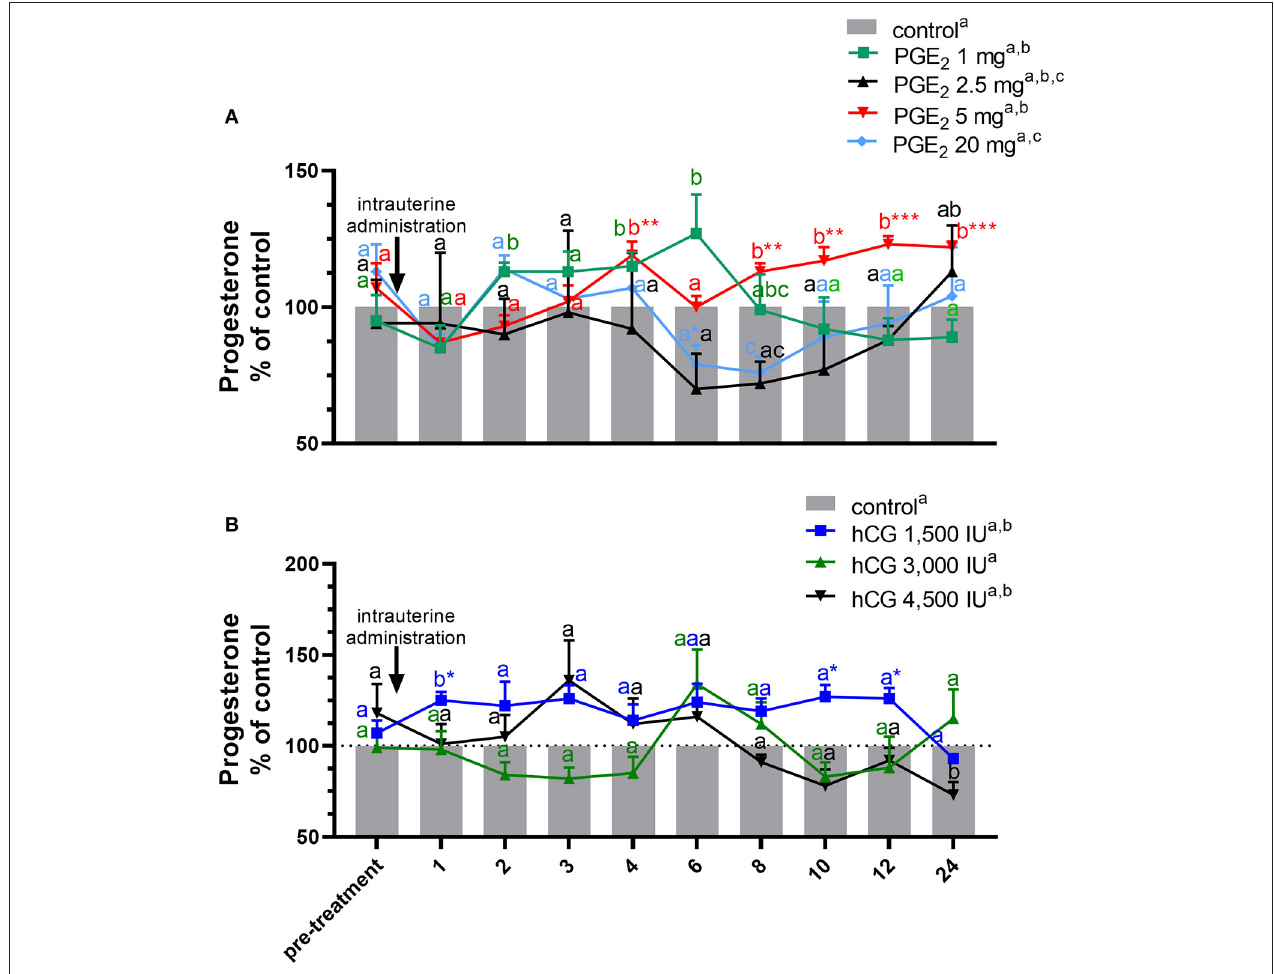
FIGURE 2 | Concentration of progesterone (P 4 ) in the jugular vein blood plasma in mares with one intrauterine administration of (A) four different doses of prostaglandin (PG) E 2 (PGE 2 ; 1, 2.5, 5, 20 mg/5ml, n = 3/dose) and (B) three different doses of human chorionic gonadotropin (hCG; positive control; 1,500, 3,000, 4,500 IU/5ml, n = 3/dose) on day 10 of the estrous cycle, compared with control groups. All values are presented as % of the control. Different superscript letters a,b,c indicate significant differences in P 4 concentrations between PGE 2 - or hCG-treated group vs. control group at specific time points of blood sample collection. Asterisks indicate significant differences between P 4 levels in PGE 2 - or hCG-treated group vs. average concentration of P 4 in blood plasma in the period before treatment (pre-treatment time: − 2 to 0h). The results were considered significantly different at p <